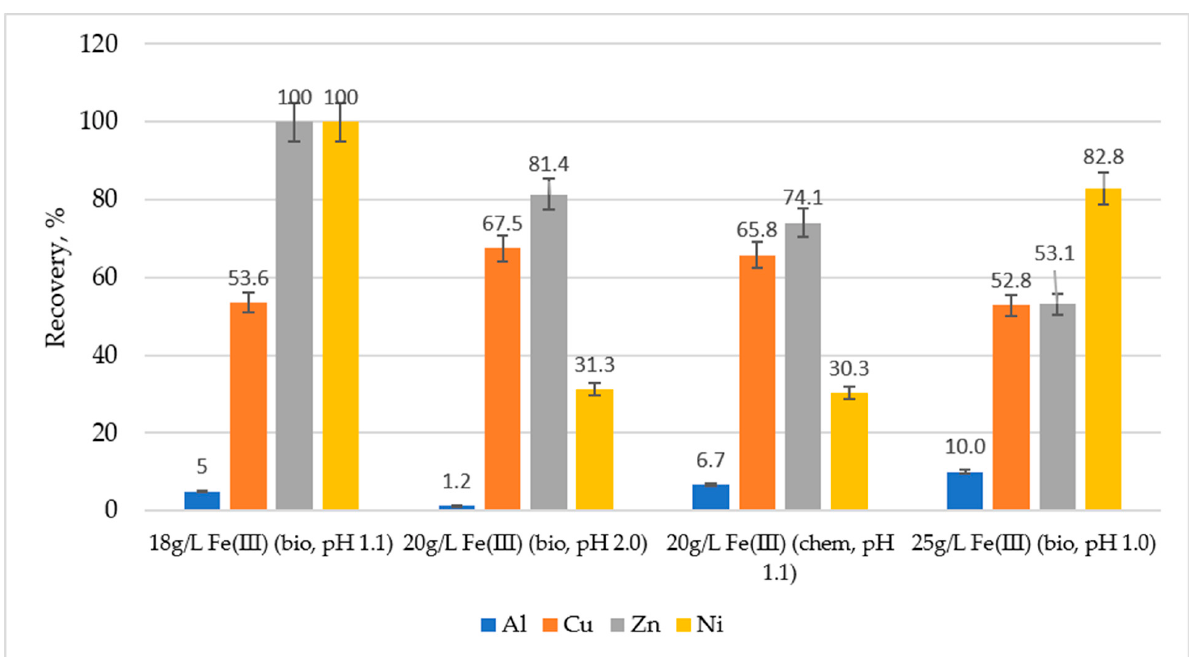
Figure 5. Metals recovery from PCBs at various concentrations of chemical and biogenic Fe 3+ and pH (PD 5%; 40 °C, air 1 lpm; 600 rpm; duration 24 h).